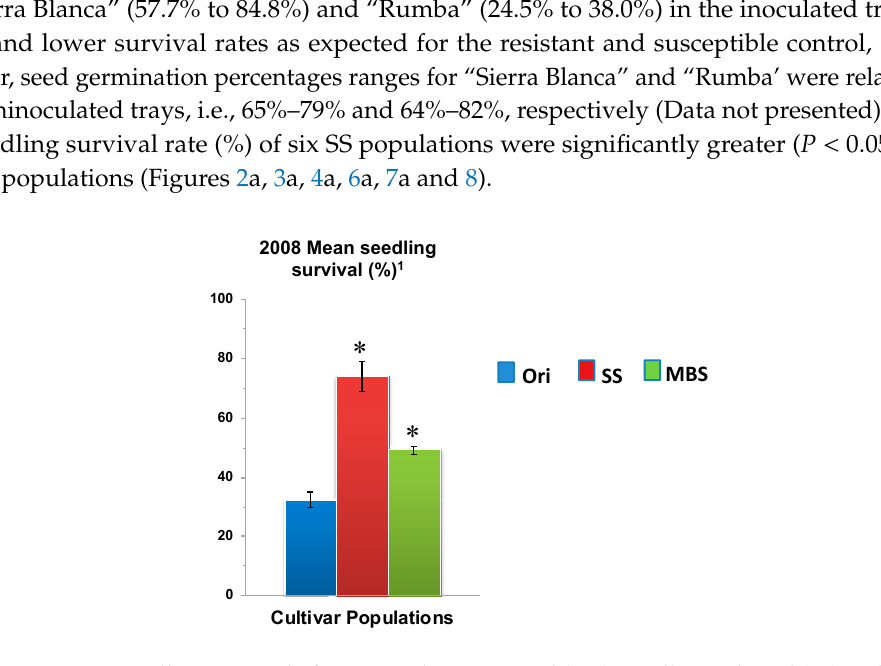
Figure 8. Mean seedling survival of NuMex Chaco Original (Ori), Seedling-selected (SS) and Mature Bulb-selected (MBS) populations for two runs in 2008 evaluation. 75 seeds of each population were sown in each tray for seedling evaluation. Std. error is shown on top of each bar. Grouping legend is provided in the right. ( * ) Significantly different from original at P = 0.05. 1 Field evaluation was not possible for NuMex Chaco due to lack of sufficient seed.